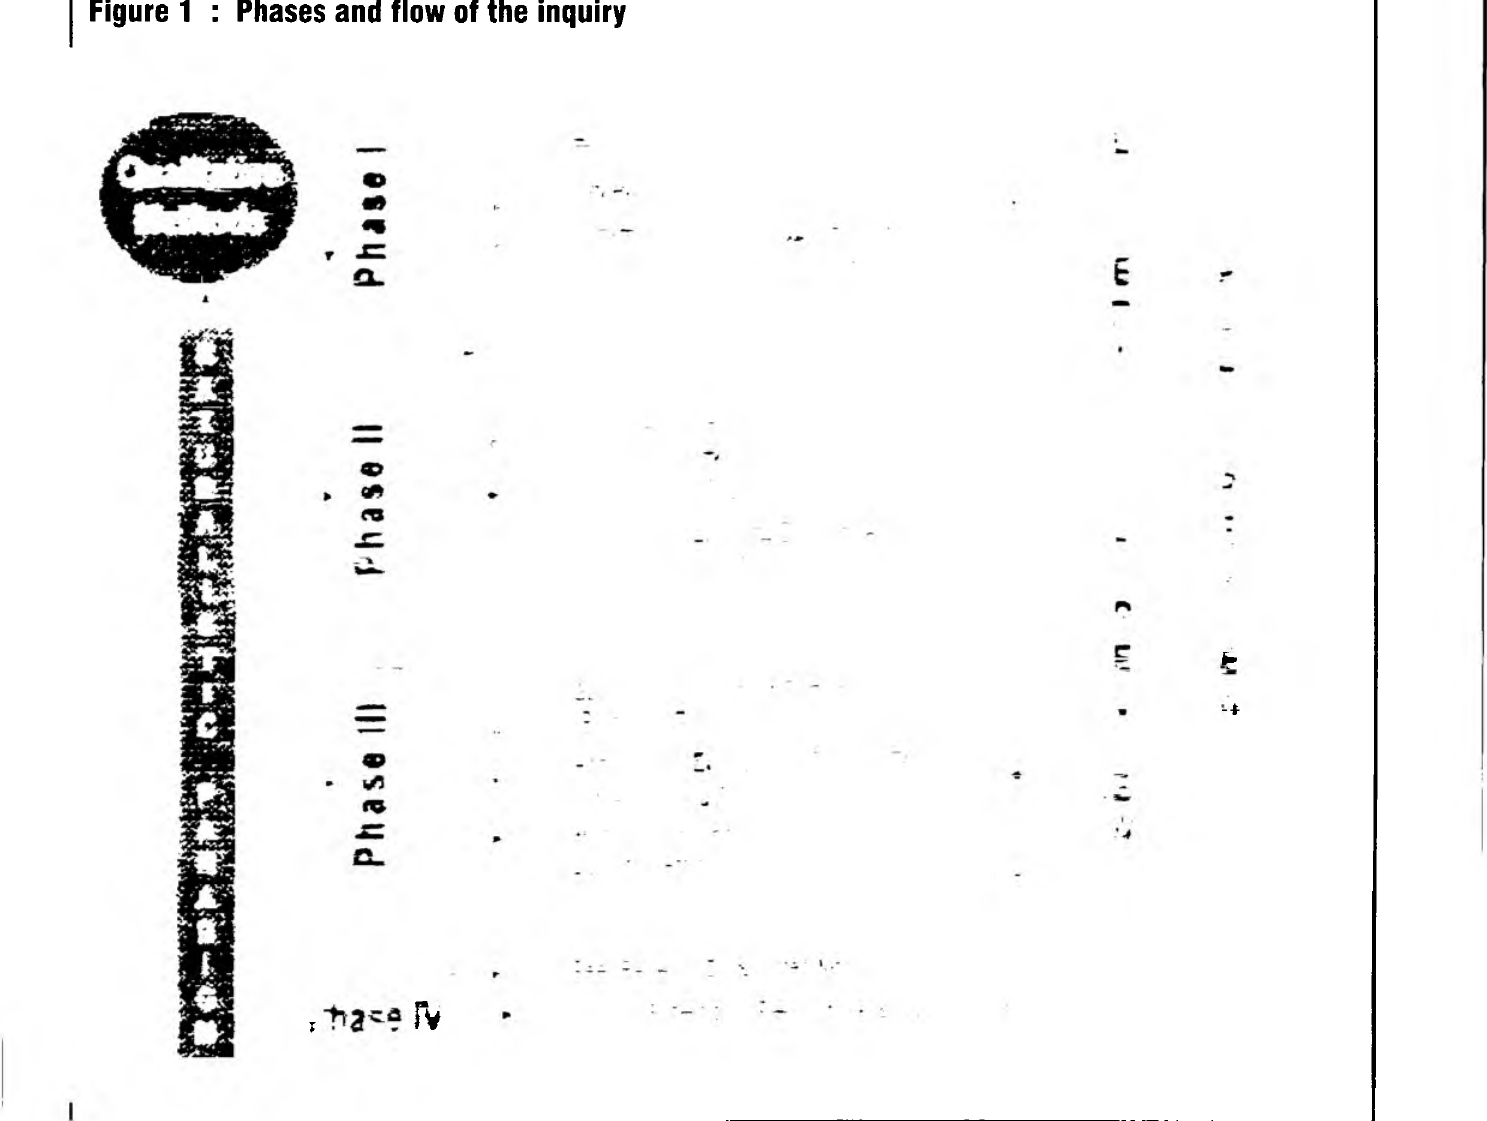
Figure 1 : Phases and flow of the